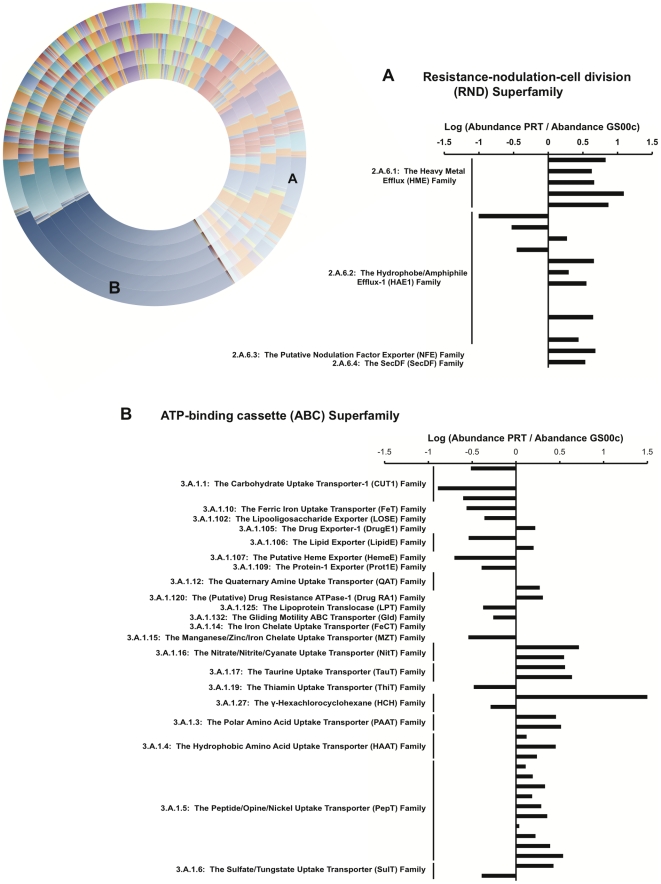
Transporter family distribution.Outer circle moving inwards: PRT, HOT4000, DeepMed, GS00d, GS00c. Log abundance profiles for (A) the Resistance-nodulation-cell division (RND) superfamily and (B) the ATP-binding cassette (ABC) superfamily are shown for the PRT compared to the GS00c. Positive values in the bar chart denote greater abundances in the PRT, while negative values are greater abundances in the GS00c for the given transporter family member. Similar results were observed for PRT and GS00d metagenome comparisons. Transporter classification details are included in the Supplementary Materials.